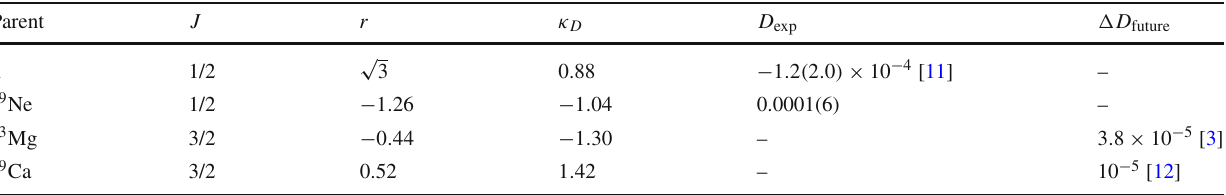
Table 1 The current experimental measurements and future experi- mental sensitivity for the D-parameter for various beta transitions. We also show the central values of the proportionality constant κ D in the